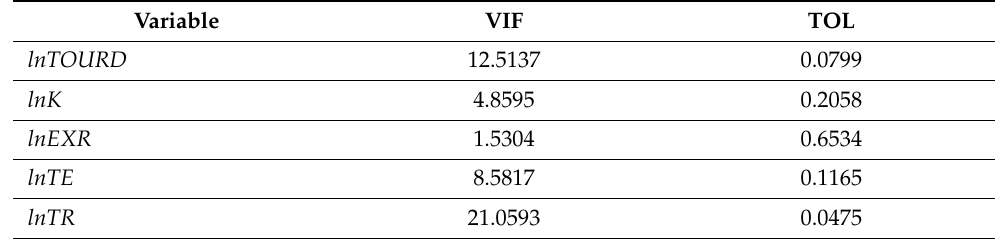
Table 3. Multicollinearity test results.